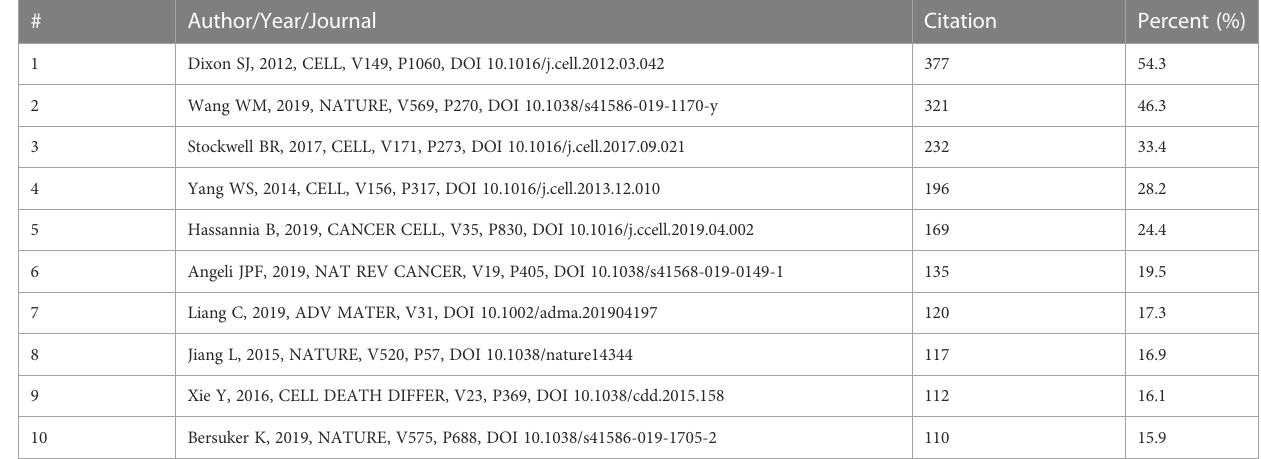
TABLE 1 Top 10 highly-cited